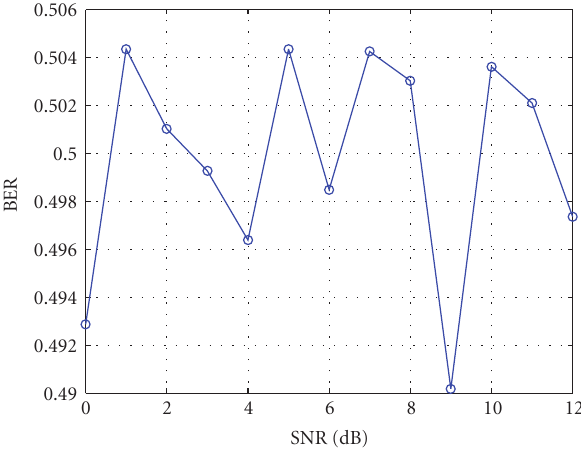
Figure 6: BER of two-train direct communication on the same track without multihop and